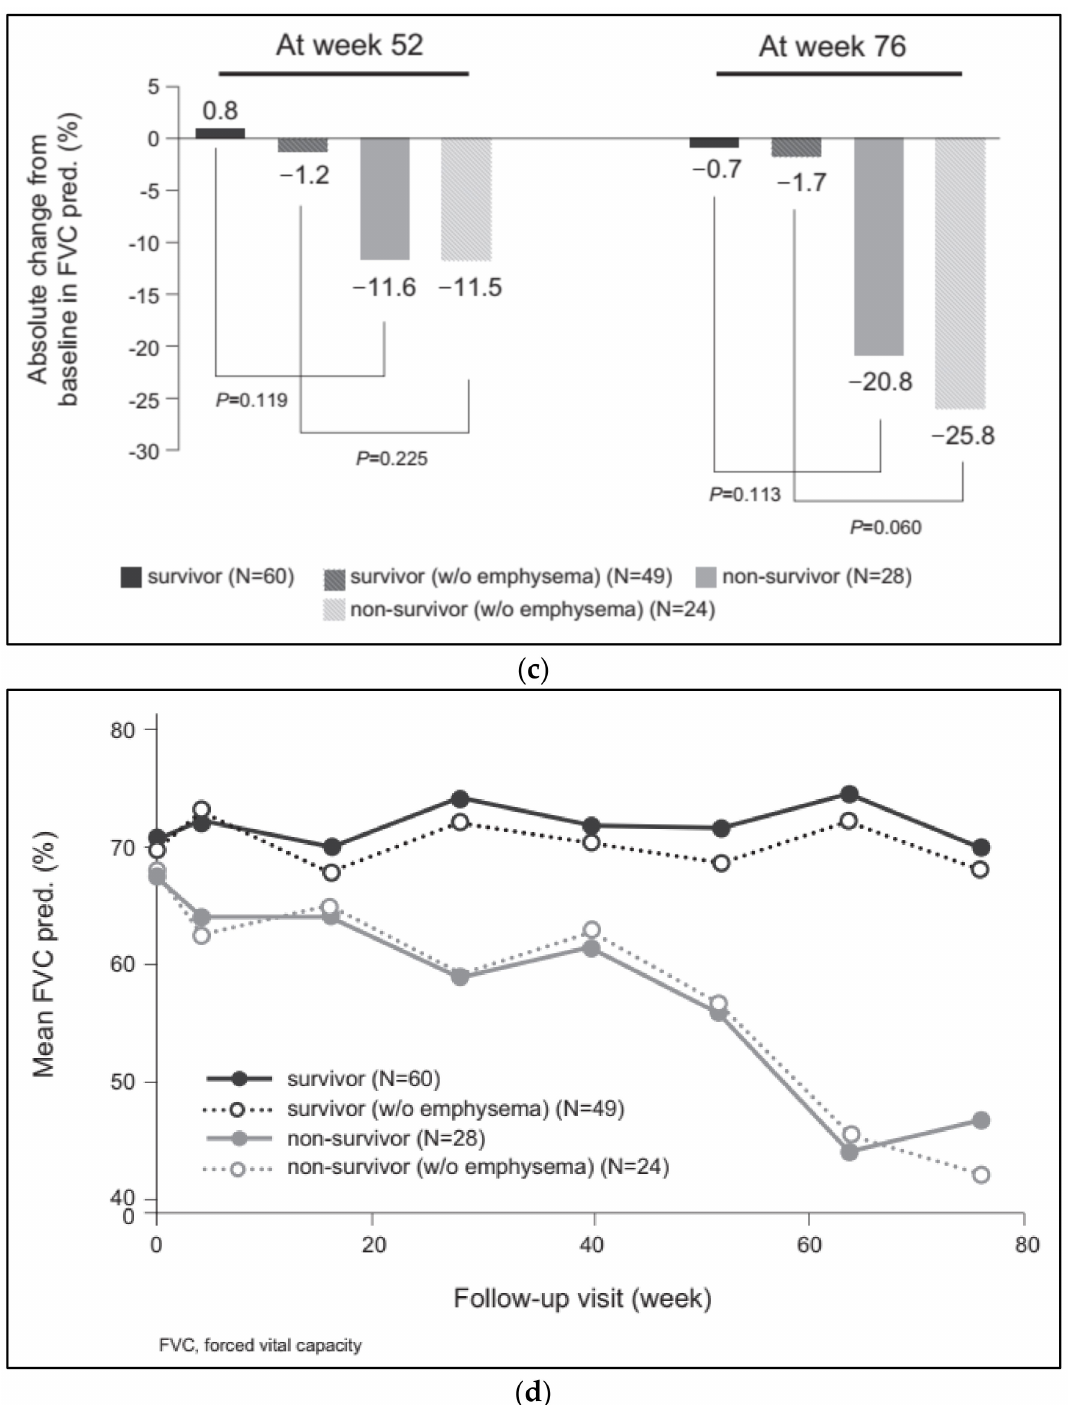
Figure 2. Changes in baseline of primary outcome parameters across the study period in the treated group. ( a ) Annual changes from baseline for the primary lung function parameters (i) forced vital capacity (FVC), (ii) diffusion of carbon monoxide in lungs (DL CO ), (iii) oxygen saturation (SpO 2 ), (iv) total lung capacity (TLC), and (v) inspiratory capacity (IC) as measured through spirometry. ( b ) Changes in percent predicted FVC from baseline, ( c ) predicted mean and absolute FVC changes in survivors and non-survivors, treated with antifibrotic drugs, and ( d ) predicted mean and absolute FVC changes in treated patients experiencing versus not experiencing at least one acute exacerbation, stratified by emphysema